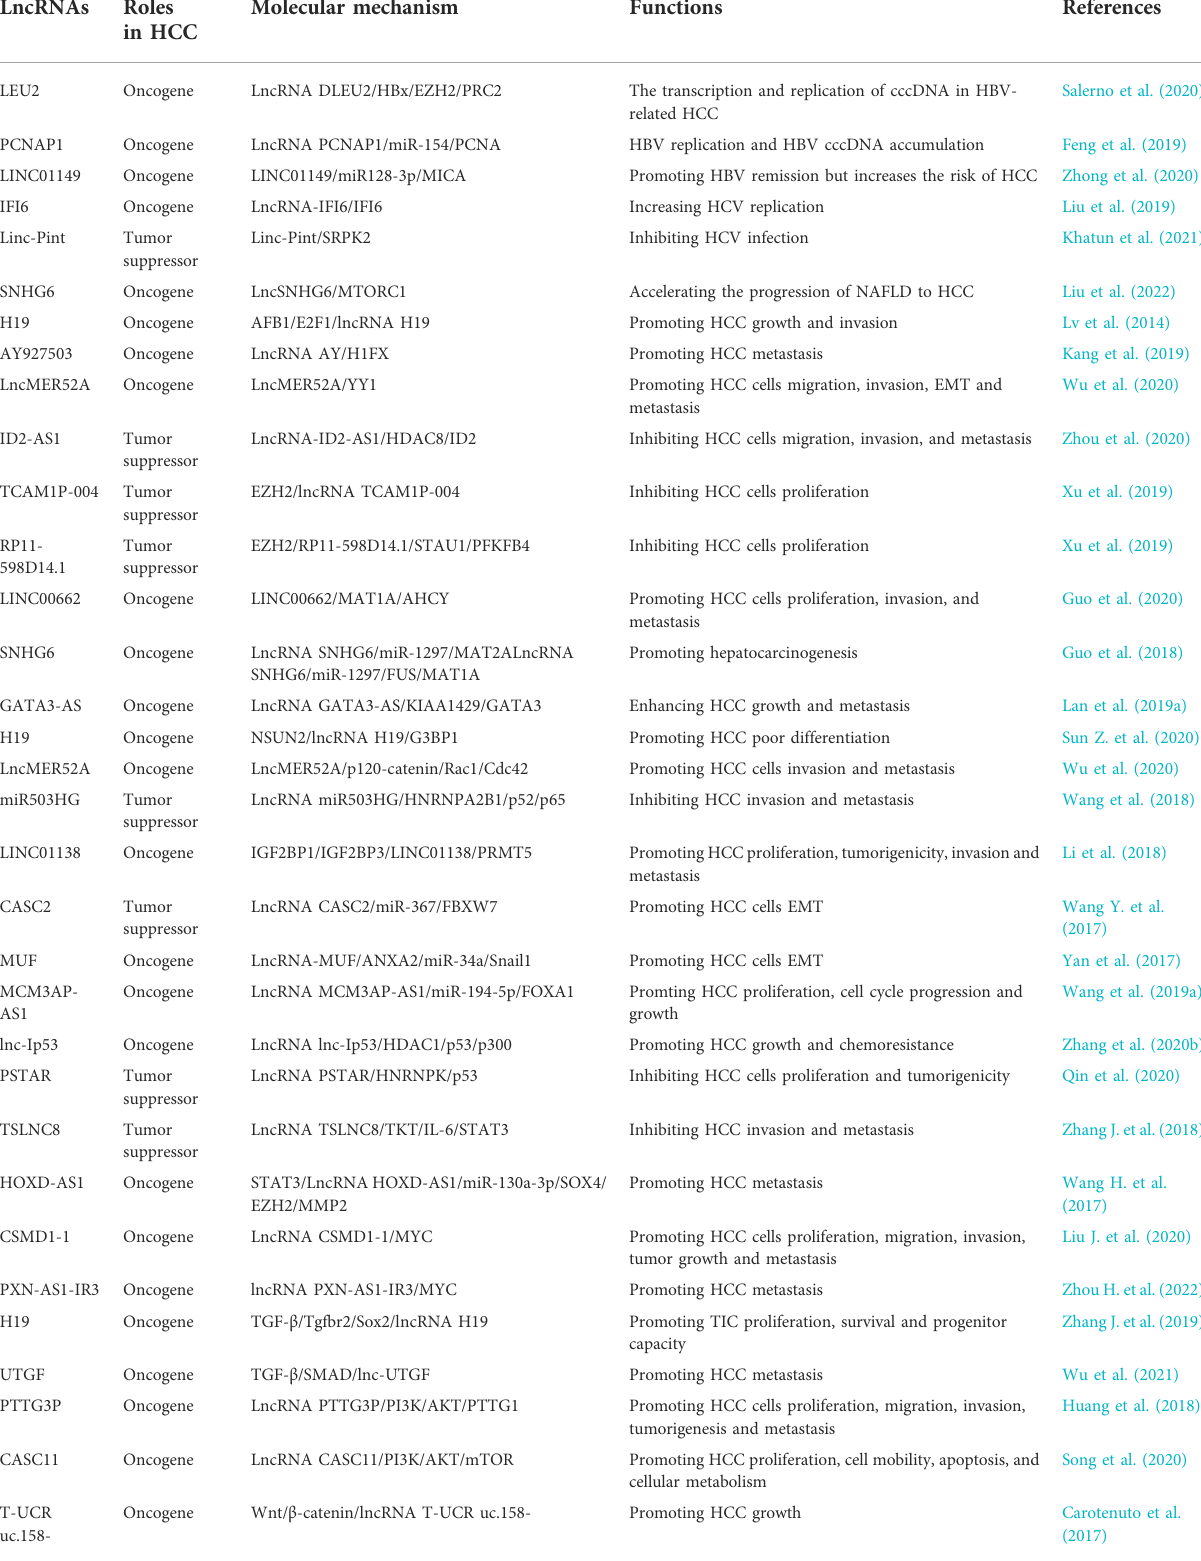
TABLE 1 Some dysregulated lncRNAs in HCC and their